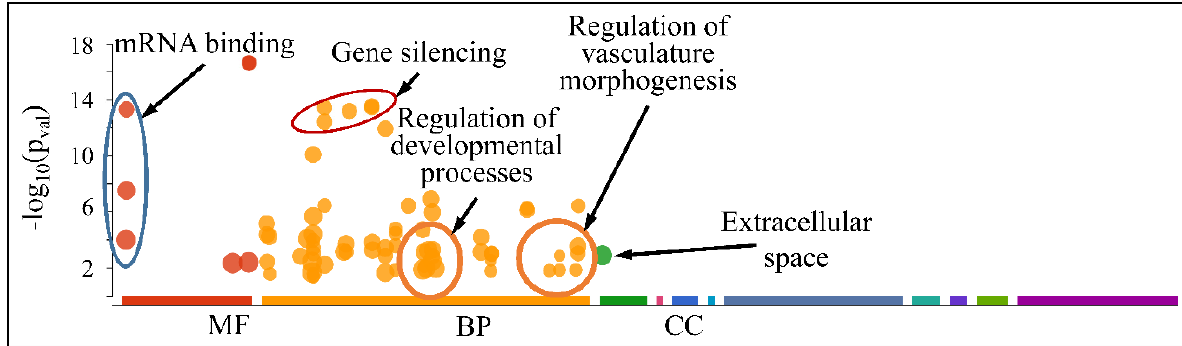
Figure 13. Functional annotation of miRNAs found globally up-regulated in all tumor samples (Legend: MF: Molecular Function, BP: Biological Process, CC: Cellular Component).